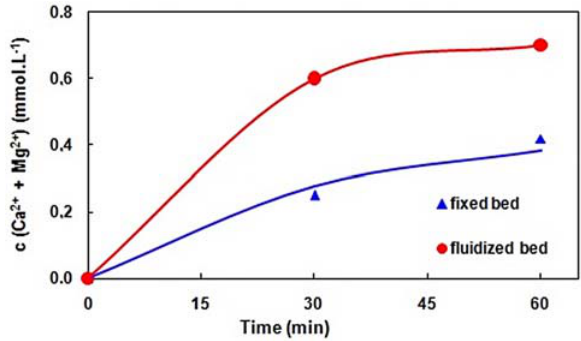
Figure 3. Time dependencies of total hardness increase using half- calcined dolomite in a fix bed reactor and in a fluidised bed reac- tor–experimental values (points) and calculated values (lines).